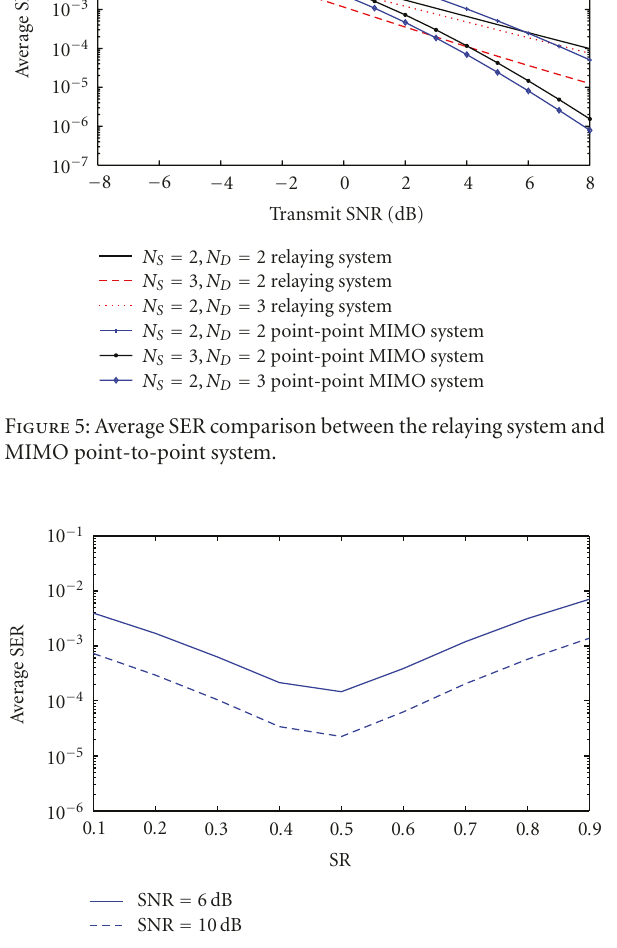
Figure 6: Average system SER versus source-relay distance. Shown are transmit SNRs of 10 and